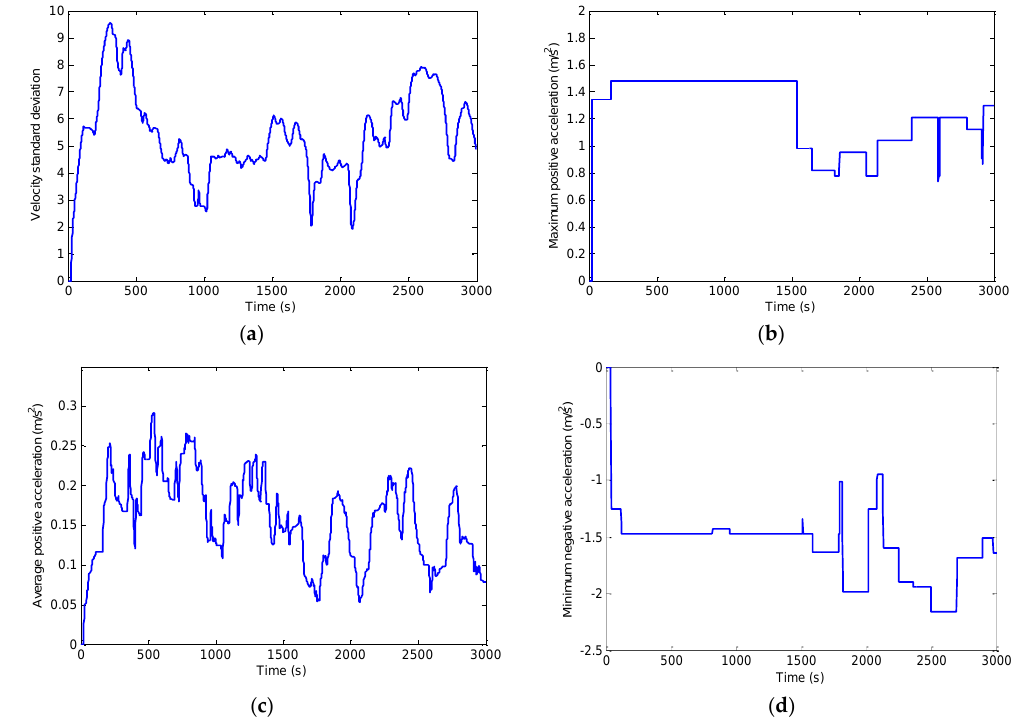
Figure 16. Characteristic parameters extracted from moderate urban driving cycle. ( a ) Velocity standard deviation; ( b ) Maximum positive acceleration; ( c ) Average positive acceleration; ( d ) Minimum negative acceleration.